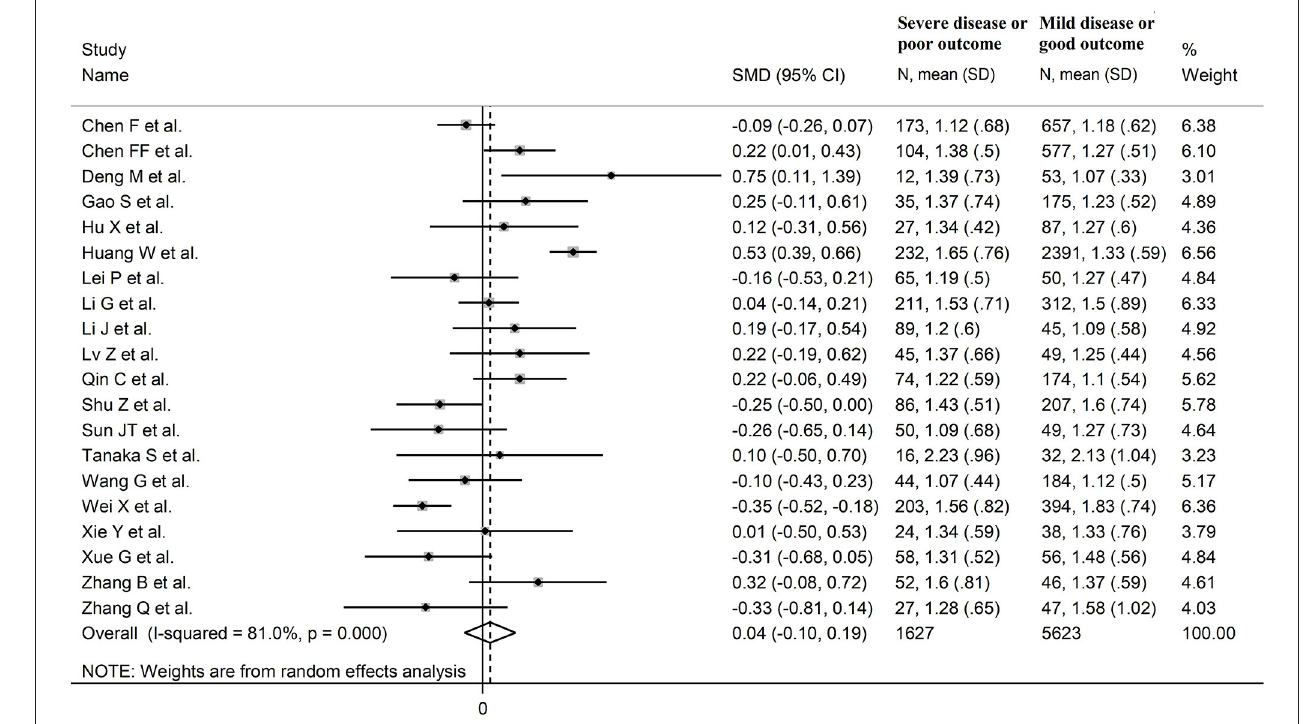
by non-specific inflammatory markers or individual